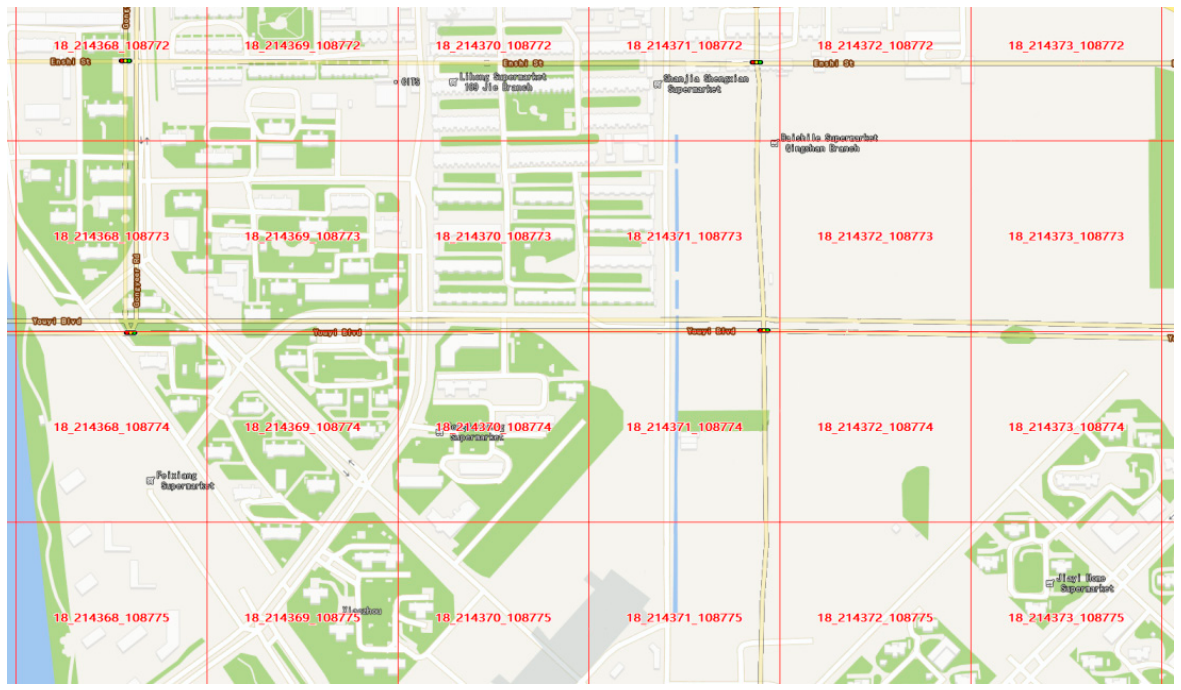
Figure 2. Mapping grid structure. Table 2. Map grid information data.